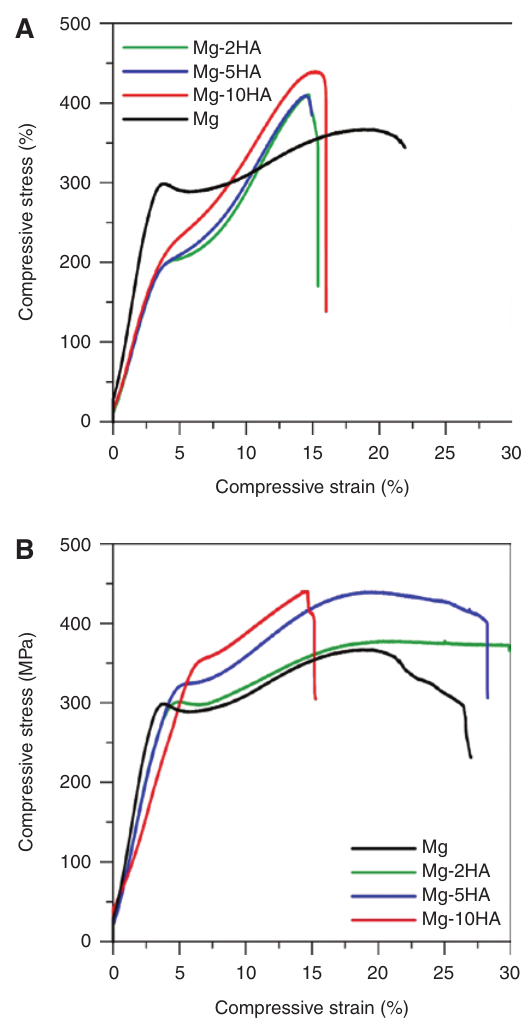
Figure 7: Compressive curves of Mg-HA prepared by (A) mixing of powders in hexane, (B) mixing of powders in planetary mill, and subsequent extrusion at 400 °